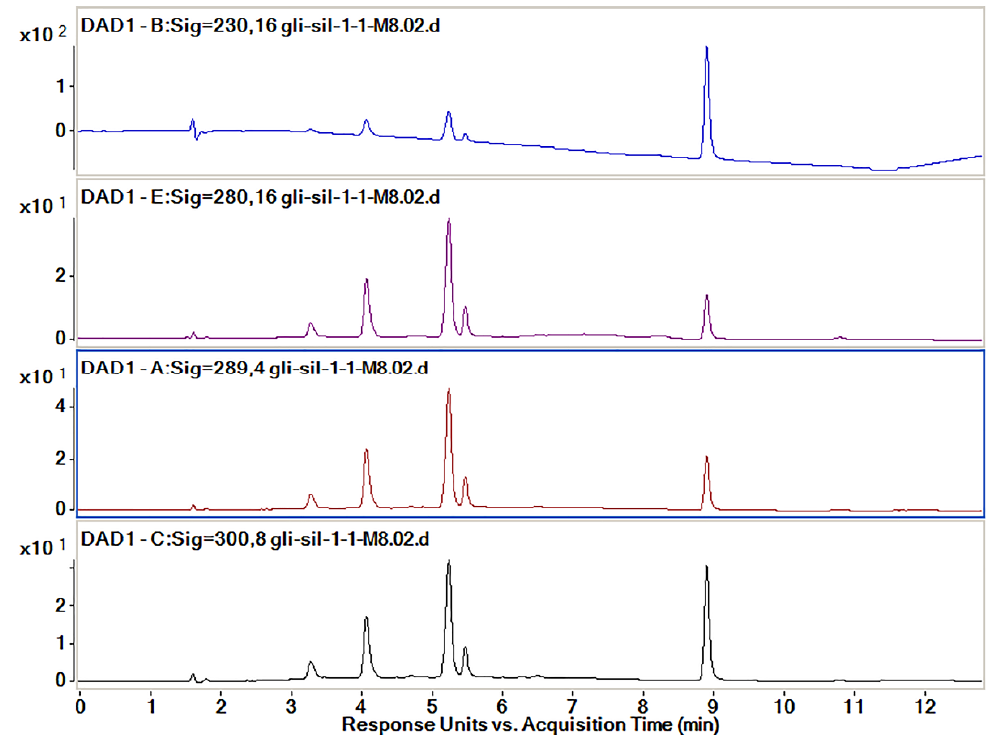
Figure 8. Chromatograms obtained by HPLC-DAD for the active substances’ mixtures at different wavelengths (230, 280, 298 and 300 nm).